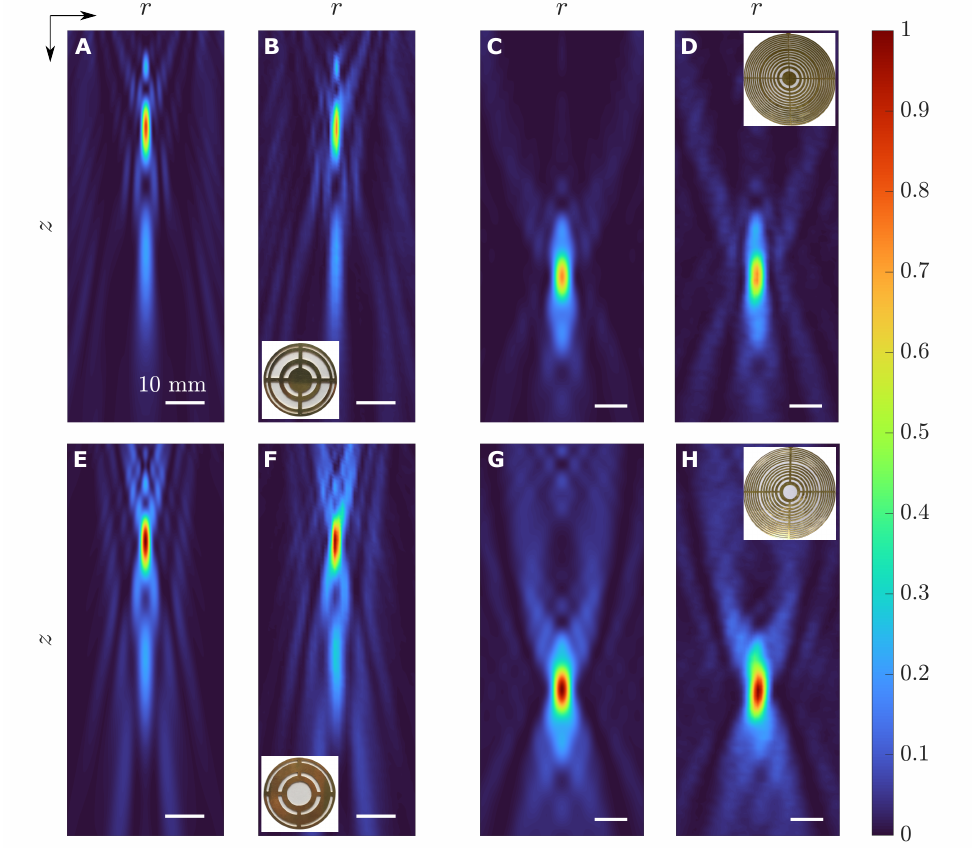
Figure 4. Intensity maps for the O-CZP case: ( A ) simulated and ( B ) experimental; O-FZP case: ( C ) simulated and ( D ) experimental; T-CZP case: ( E ) simulated and ( F ) experimental; and T-FZP case: ( G ) simulated and ( H ) experimental. Each experimental intensity map shows an inset with an image of the corresponding manufactured lens. All maps have been normalized to the maximum intensity values, corresponding to the cases with the transparent central region.